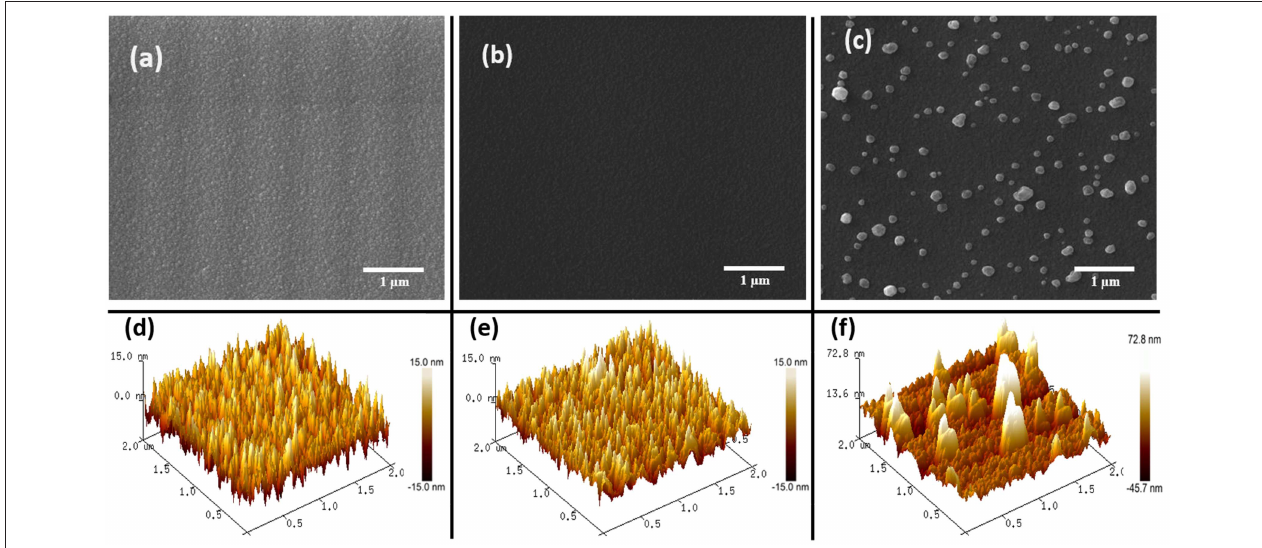
FIGURE 2 | (a–c) FESEM images of as-deposited SnO 2 , annealed SnO 2 , and AgNPs/SnO 2, respectively. (d–f) AFM images of as-deposited SnO 2 , annealed SnO 2 , and AgNPs/SnO